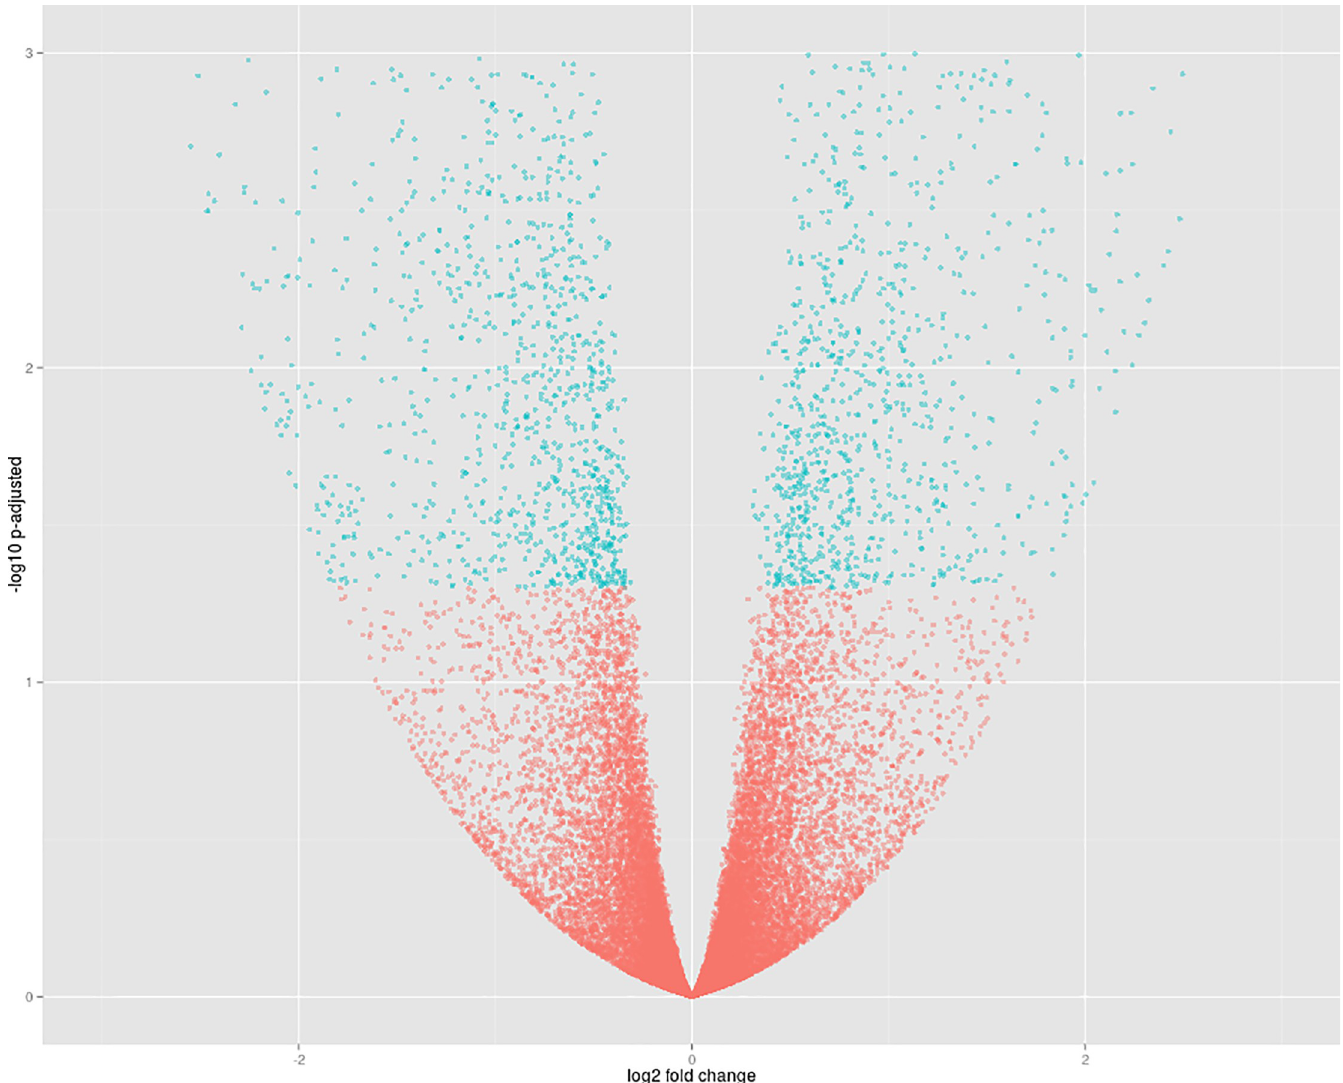
Fig 3. Volcano plot of comparison 3. Dots in blue represent significant differentially expressed genes. The genes of the IAC Imperador genotype under restrictive P (Libraries 1–3) are represented to the left of the origin of the coordinate plane, and the genes of the IAC Imperador genotype under control P (Libraries 7–9) to the right.